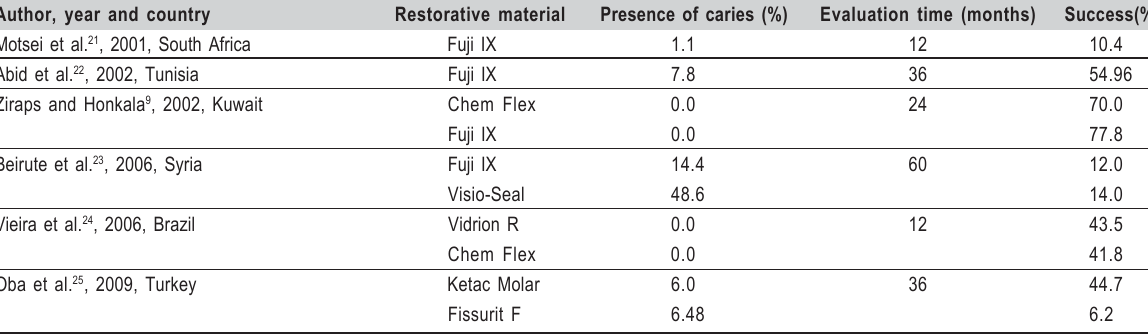
Table 4. Distribution of studies on sealants used with